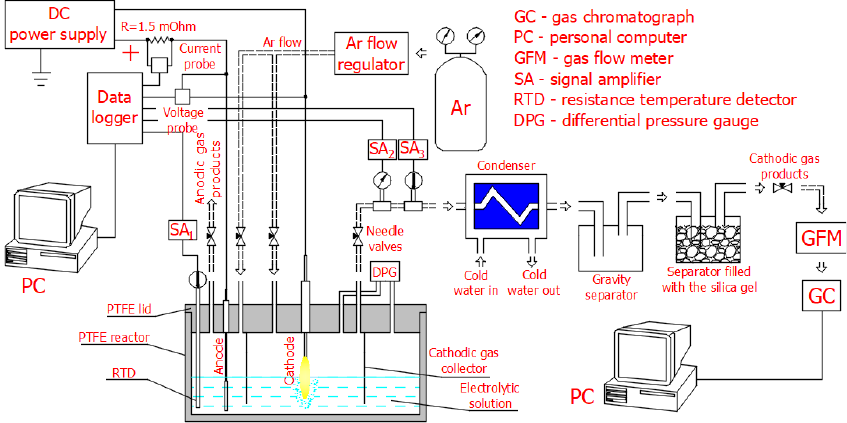
Figure 1. Scheme of the experimental setup used to study hydrogen production at the discharge electrode in the DC electrolysis of a 10 wt% Na 2 CO 3 aqueous solution in 3 regimes: Faradaic, tran- sition, and PDSE.